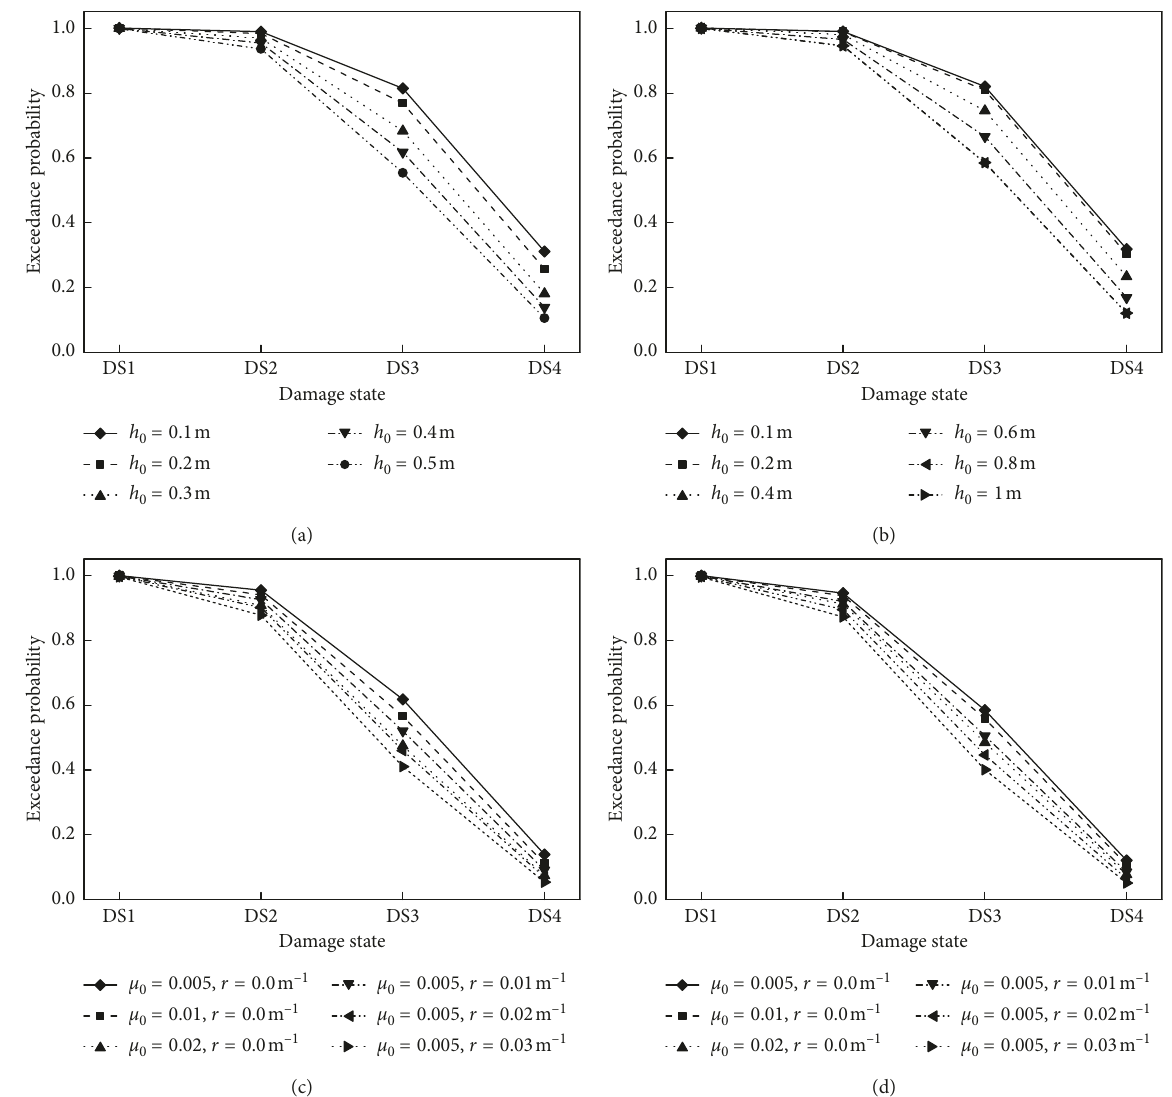
Figure 11: Structural peak relative displacement when K DS3, and DS4 are defined by the structural peak relative displacement in Table 2). (a) μ 0 1 , h . 0m. (c) h r 0.0m 1 (cid:31) 1 (cid:31) −